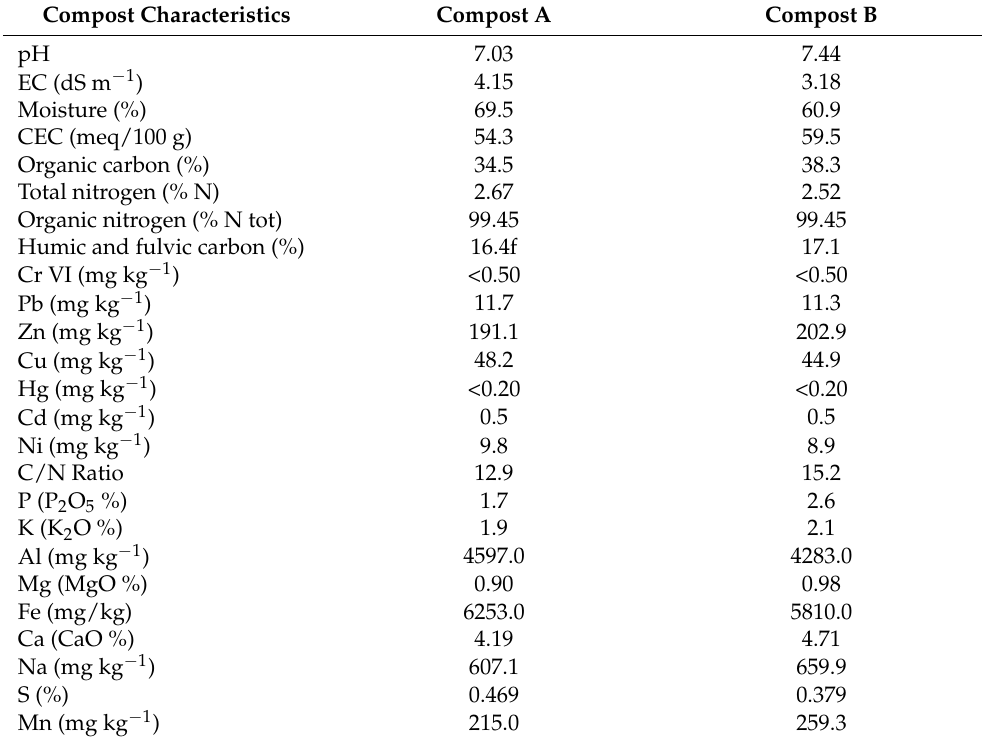
Table 2. Chemical characteristics of the compost from digestate and grapevine pruning wood (A) or digestate and hazelnut shells and seed skin (B). All values are on a dry weight